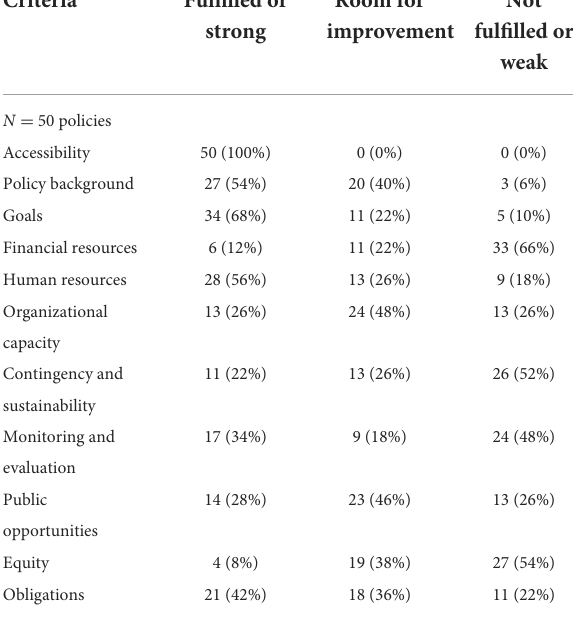
TABLE 4 Criteria assessment on the internal validity of waste management policies. Criteria Fulfilled or